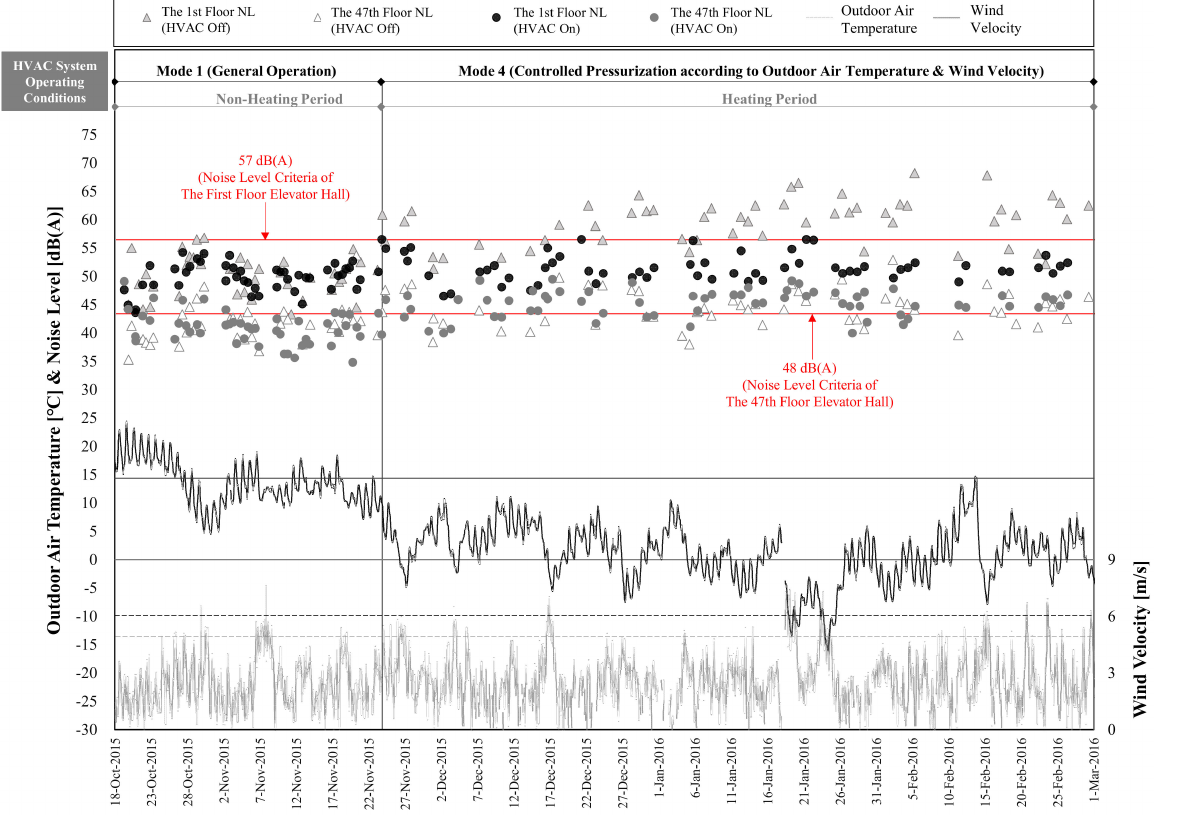
Figure 10. Noise distribution on 1st- and 47th-floor elevator halls (Winter